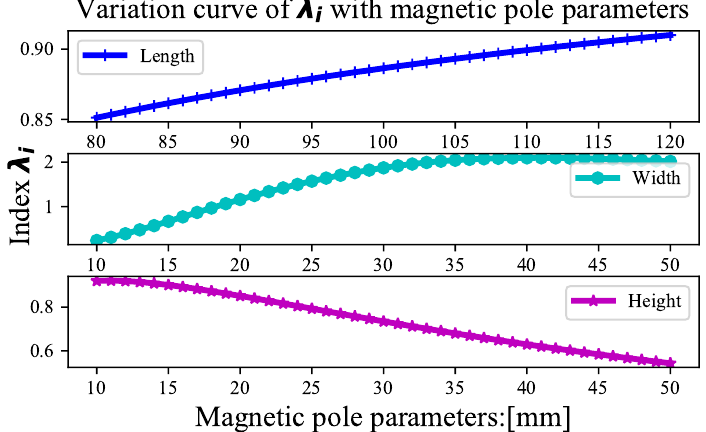
Figure 18. Variation curve of the evaluated index λ i with magnetic pole size parameters.